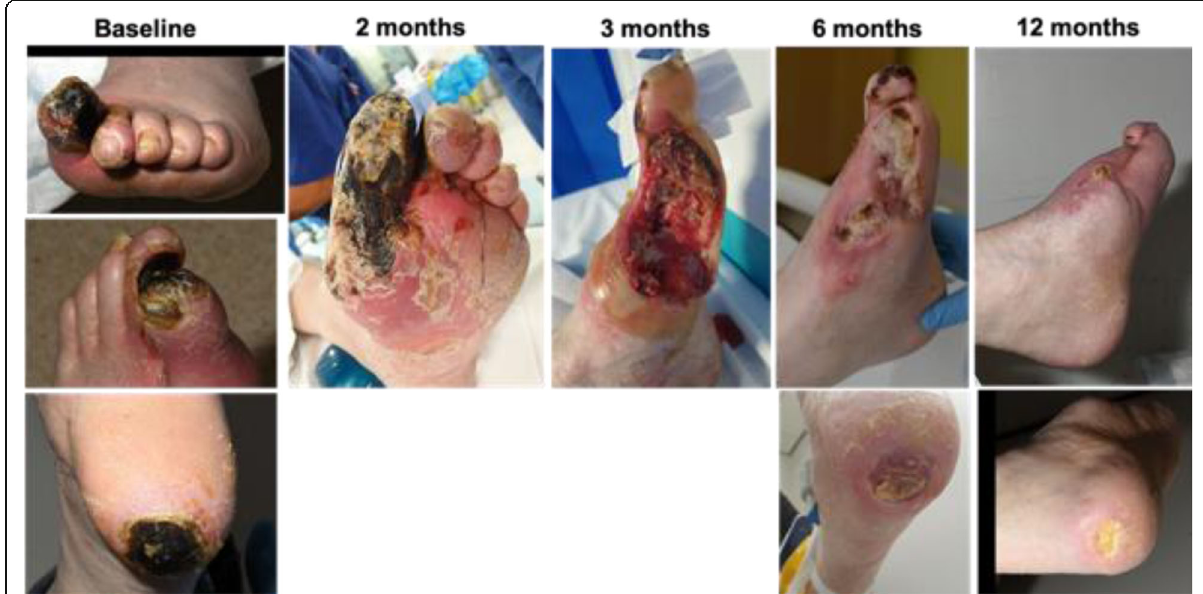
Fig. 2 Progression of wound healing baseline to 12 months post pDVA)